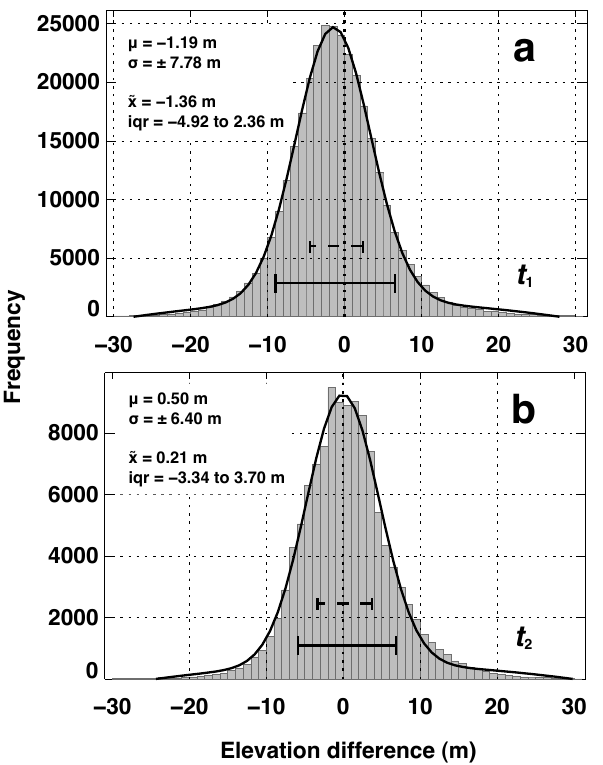
Figure 4. Distribution of (a) DHM25 Level 1 minus photogrammet- rical DEM differences at t 1 and (b) swissALTI 3D minus photogram- metrical DEM differences at t 2 over selected glaciers with available independent, photogrammetrically derived DEMs. The black curves are normal fits over the data, the solid bars mark the standard devia- tion at the 1 σ level and the dashed bars the interquartile range (iqr). In addition, the mean ( µ ) and median ( e x ) elevation differences are